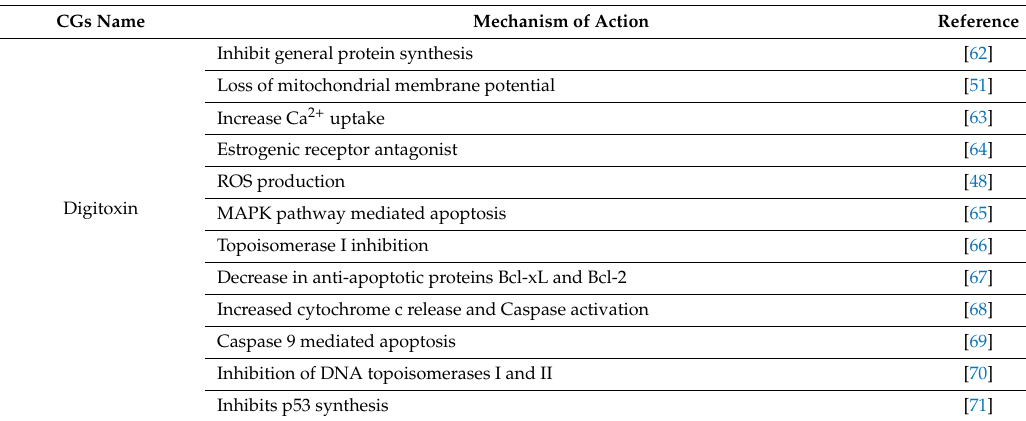
Table 1. List of CGs and their mode of action in various cancer cells to induce apoptosis, cell cycle arrest and autophagic cell